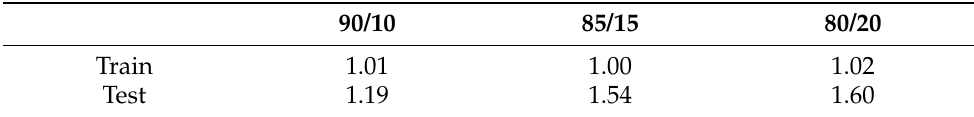
Table 8. Average RMSE sensitiveness analysis of three different training/test ratios 90/10, 85/15 and 80/20.